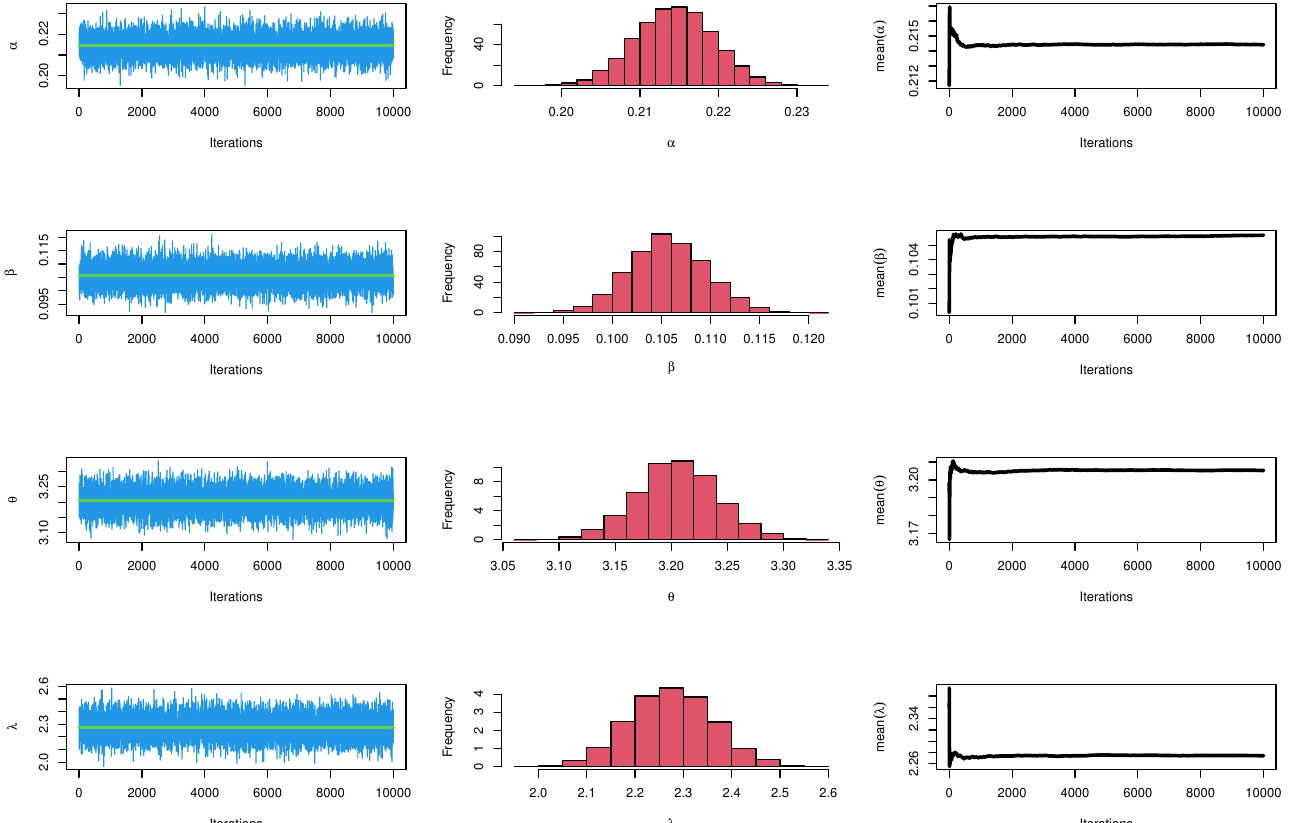
Figure 27. MCMC plots for parameters of TLMW model for single carbon